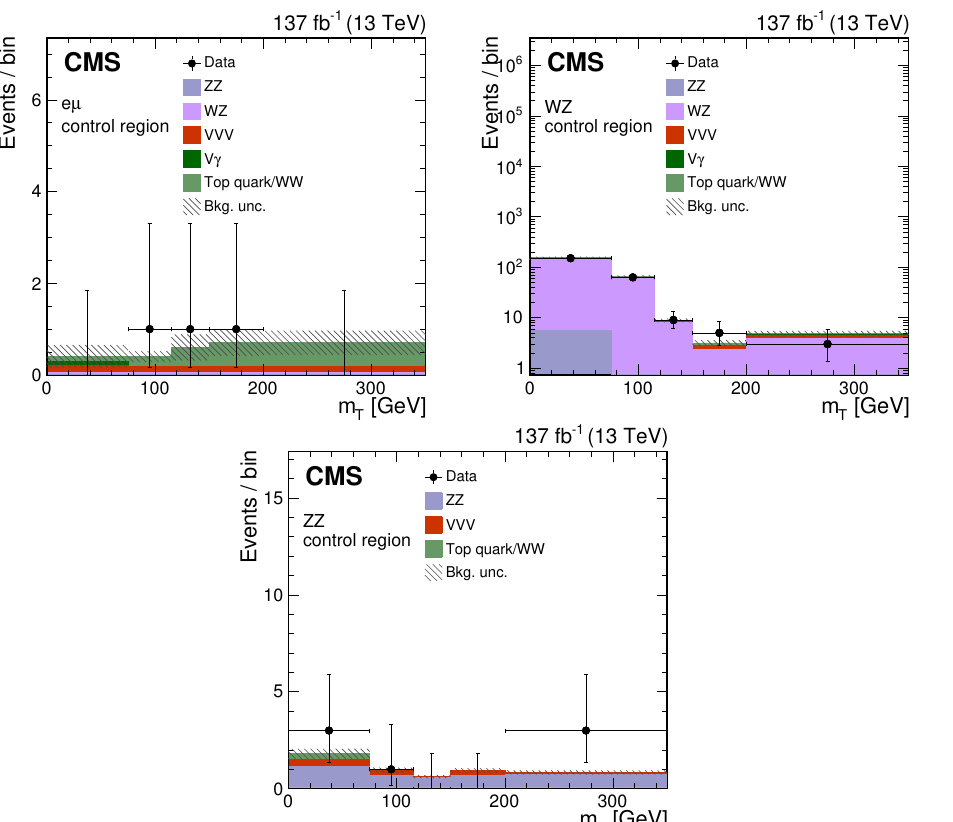
Figure 2 . The m distributions for the e (cid:22) , WZ, and ZZ control regions after the simultaneous (cid:12)t T to data in the signal and control regions. Statistical and systematic uncertainties in the expected background yields are represented by the hatched band. Vertical bars represent data statistical uncertainties, while horizontal bars represent the bin